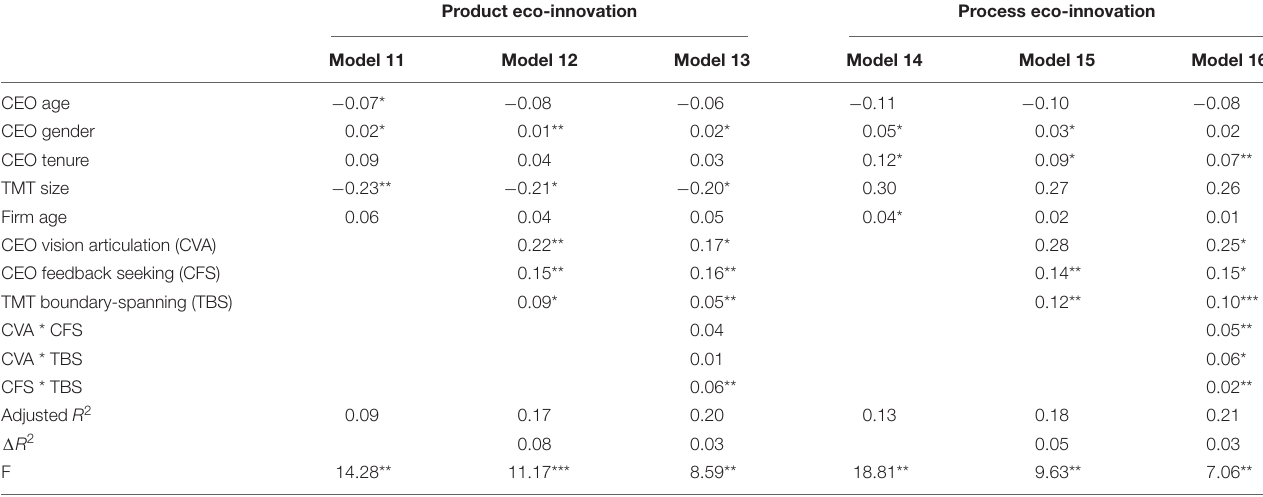
TABLE 3 | Hierarchical regressions on product and process